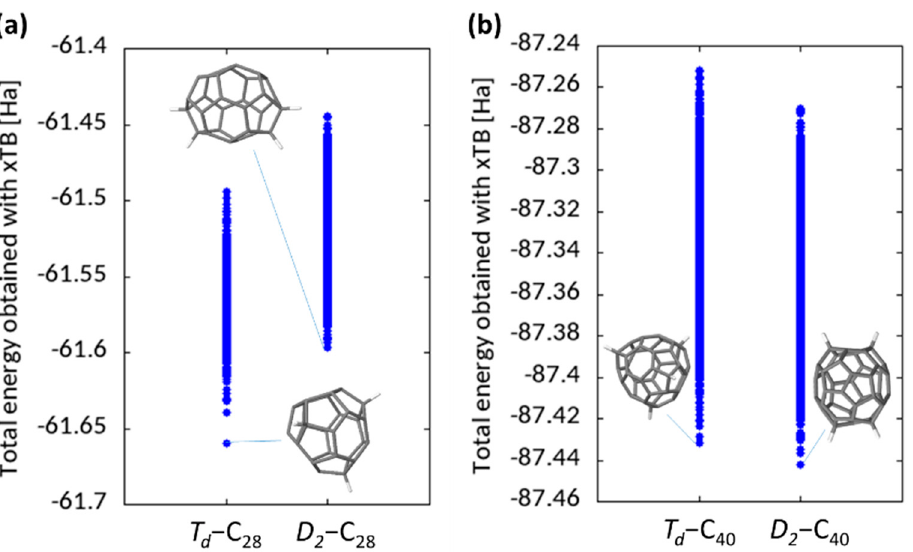
Figure 8. Calculated total energy of all the possible ( a ) C 28 H 4 and ( b ) C 40 H 4 for T d and D 2 isomers obtained by GFN2-xTB, with lowest-energy structures labelled.